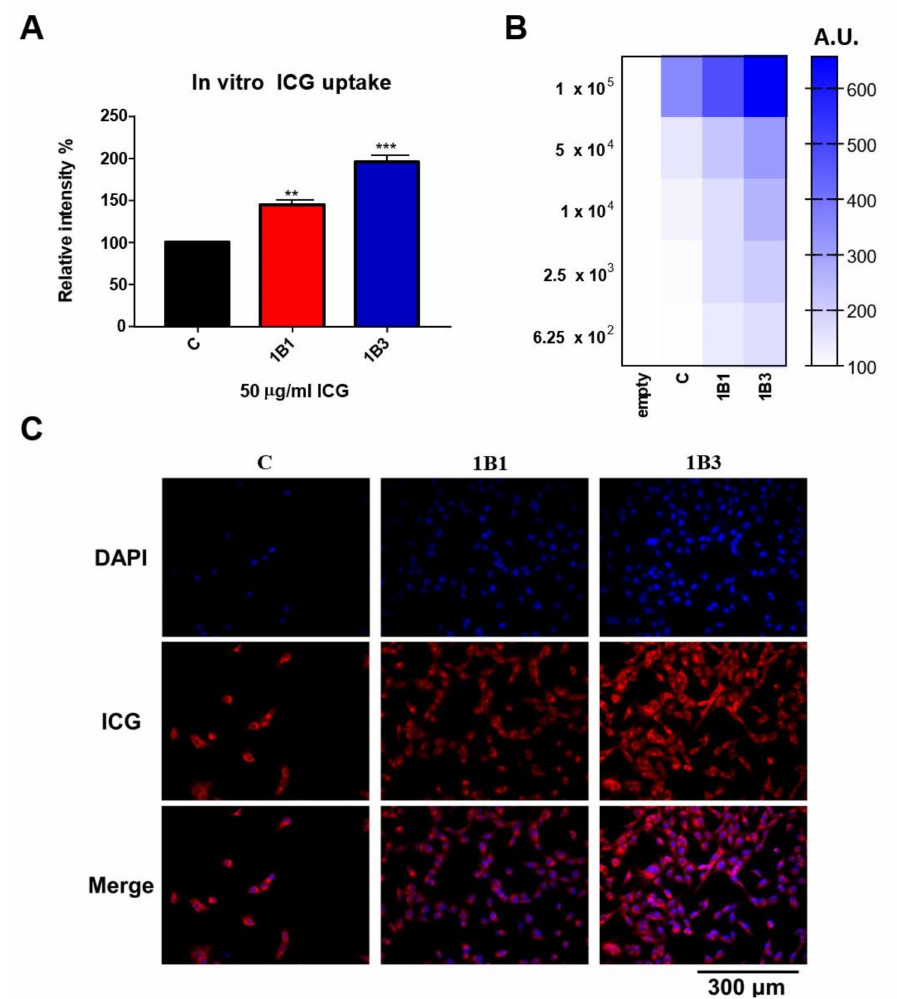
Figure 6. In vitro ICG uptake in HT1080 cells. ( A ) OATP-expressing and untransduced HT1080 cells were treated with 50 µ g/mL ICG for 1 h. After washing with PBS three times, the signals were detected with a fluorescence reader ( n = 3). Error bars show the SEM, and ** and *** represent p < 0.01 and p < 0.001, respectively. ( B ) A serial dilution of cell numbers was imaged with the fluorescence reader and normalized against the control cells. ( C ) One hour after ICG was added to the OATP1B1-, OATP1B3-expressing and control cells, the cells were monitored under fluorescence microscopy. The ICG was represented in red, whereas cell nucleus were stained by DAPI (blue). C, control; 1B1, OATP1B1-expressing cells; 1B3, OATP1B3-expressing cells. A.U., Absolute